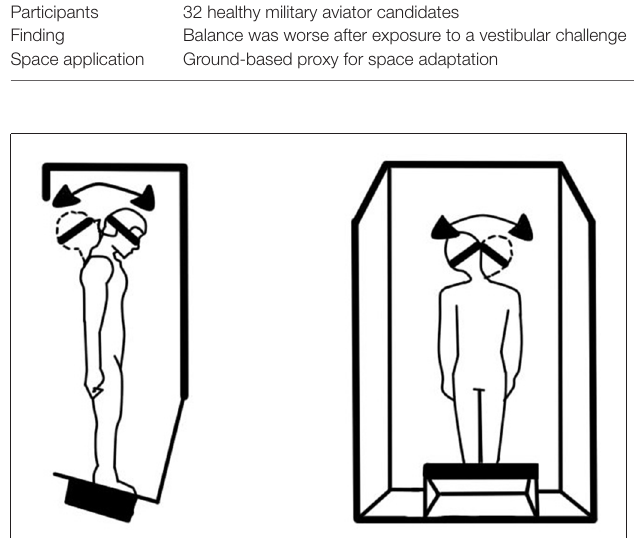
FIGURE 2 | Schematic of the modified Sensory Organization Test 5 (SOT5) explored in Study #2, which required the subject to make head movements while balancing without helpful cues from vision (eyes closed) or ankle kinesthesia (unstable